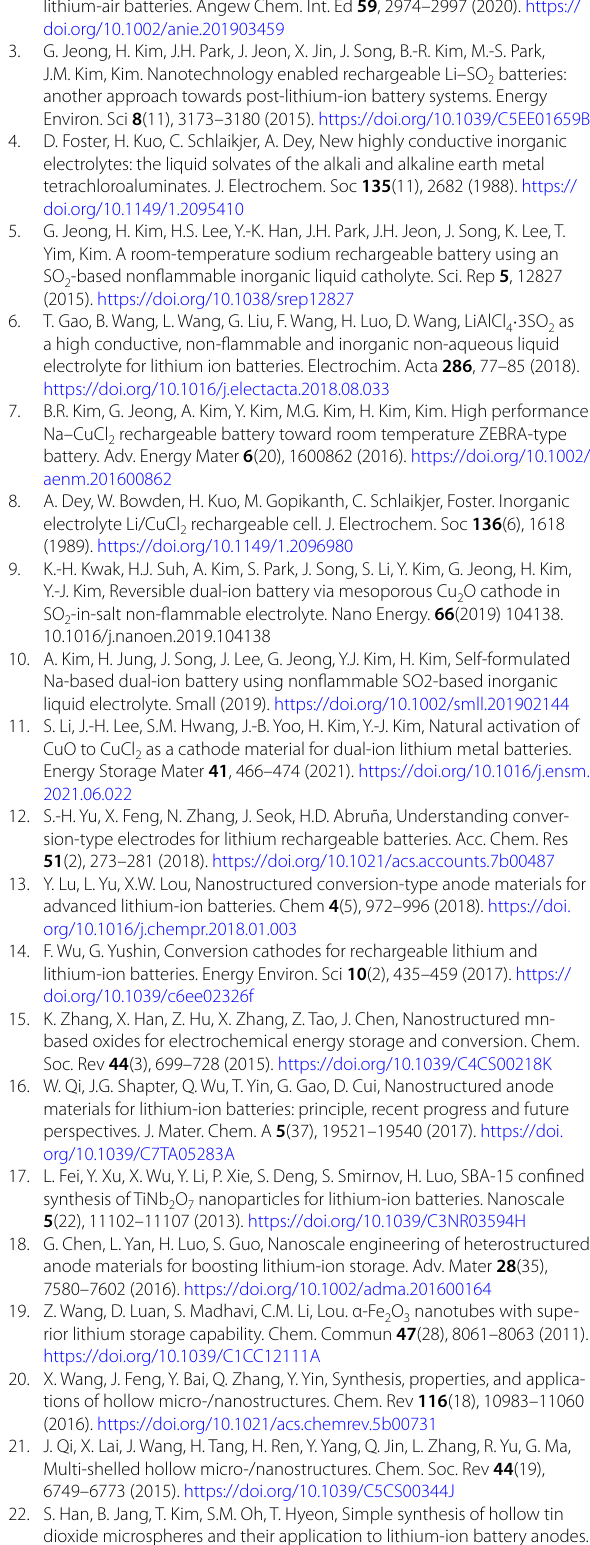
Additional file 1: Figure S1. Schematic of conversion reaction for the cathode active materialsduring resting and cycling. Crystal